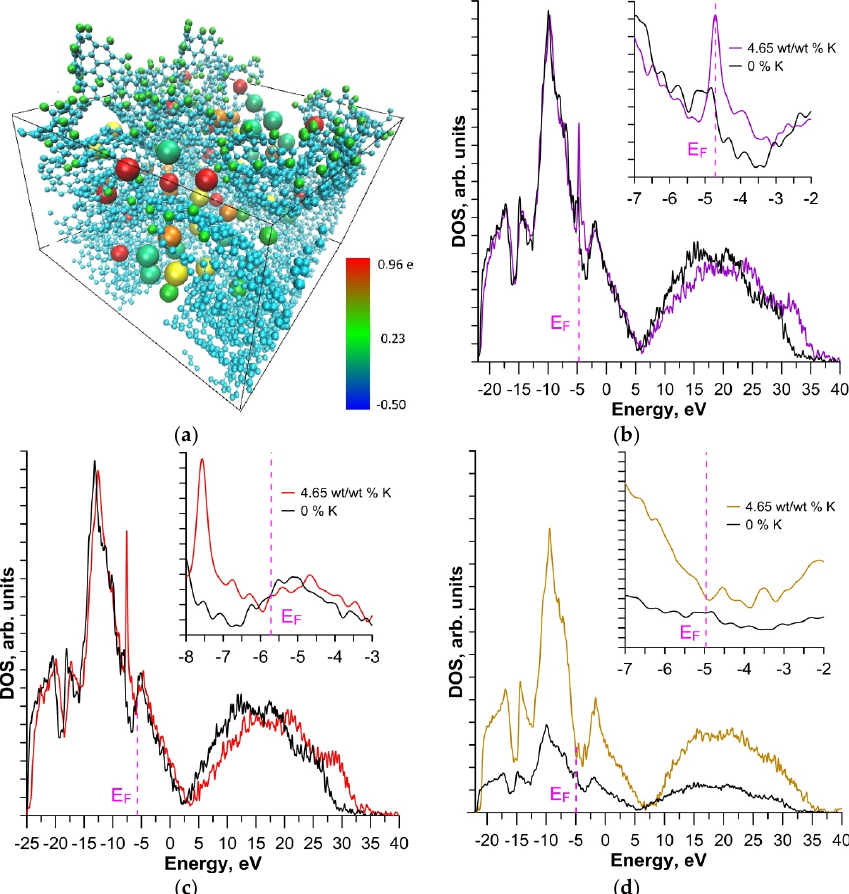
Figure 4. Distribution of the electron charge: ( a ) on a surface modified by hydrogen atoms with a concentration of 3.56%, with a maximum mass fraction of potassium; ( b ) Density of states (DOS) of hydrogenated (3.56%) surface without potassium (gray curve) and with potassium (lilac); ( c ) DOS of oxidized (1.12%) surface without potassium (gray curve) and with potassium (red); ( d ) DOS of a clean surface without potassium (gray curve) and with potassium (ocher color).